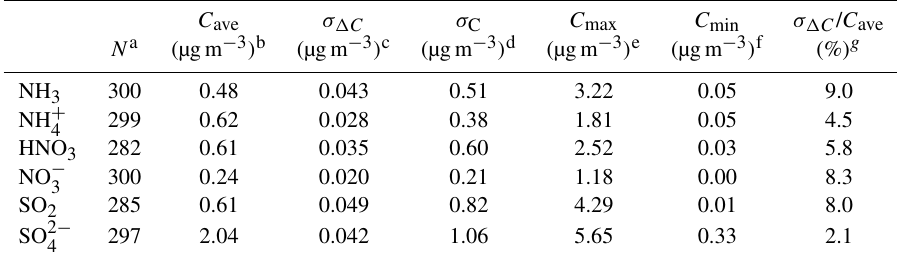
Table 2. Summary of colocation